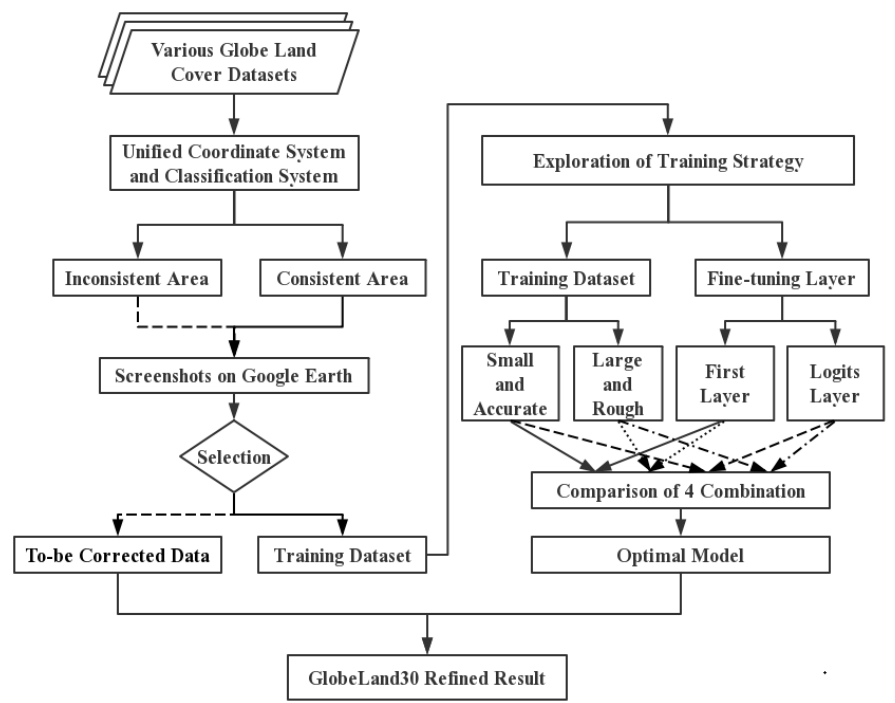
Figure 1. Flowchart of GlobeLand30